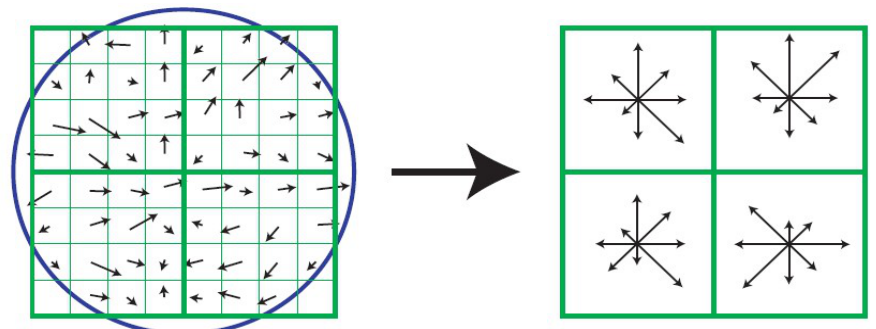
Figure 5. SIFT Descriptor.